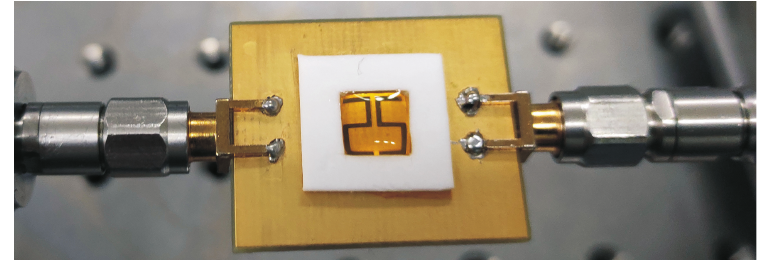
Figure 7. Complementary metaresonator sensor loaded with the OUT.